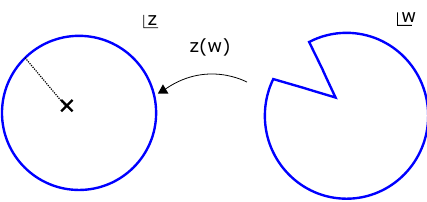
Figure 10 . The transformation w ( z ) = z θ replaces the twisted angular periodicity in the w - coordinates with a conical defect in the z -coordinates. The z -plane has a branch cut which hits the boundary somewhere and marks